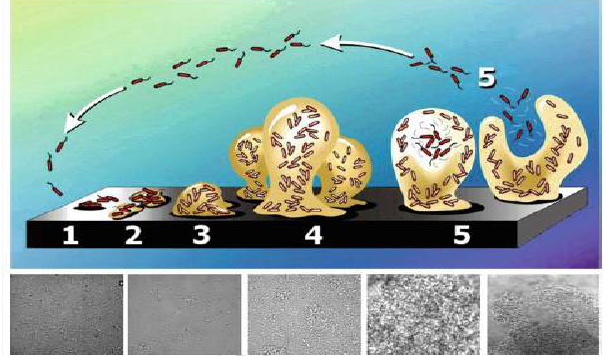
Figure 34. Depicts the lifetime of a biofilm. The stages of biofilm formation and dispersion are depicted from right to left. The lower panel contains photomicrographs of bacteria at each of the five phases depicted in the above schematic [154].